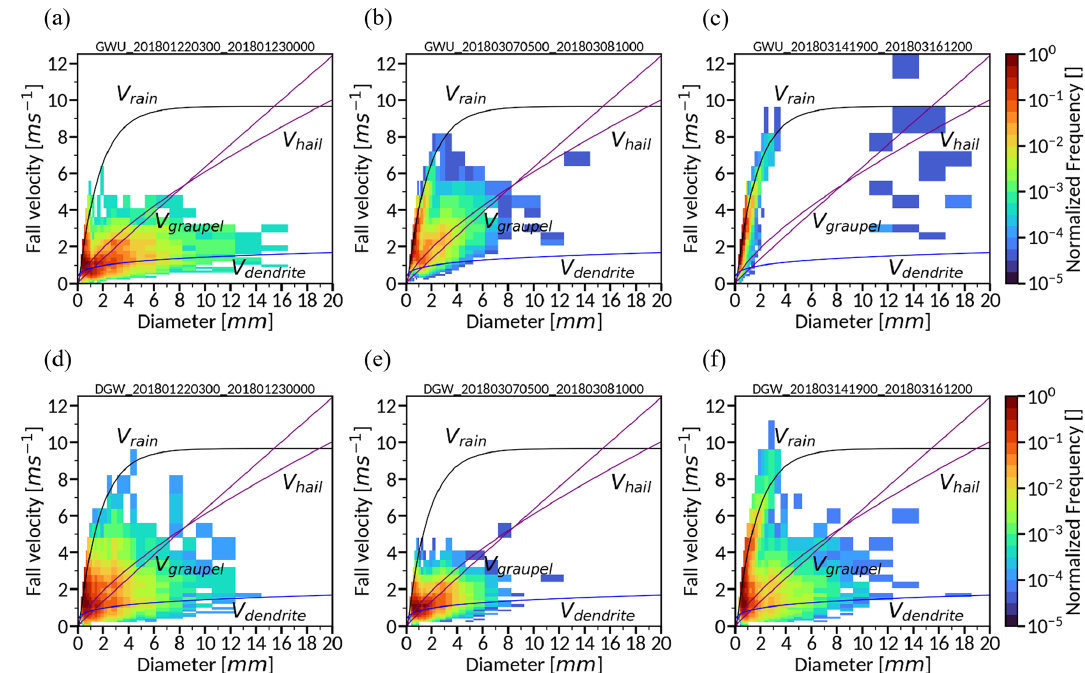
Figure 2. Normalized frequency of the measured precipitation particle fall velocity as a function of diameters at the GWU (a–c) and DGW (d–f) sites. Panels (a) and (d) are for case 3, panels (b) and (e) are for case 6, and panels (c) and (f) are for case 7 during the analysis period. The solid lines represent the relationship between the fall velocity and diameter for rain (using the power law fit from the Gunn and Kinzer, 1949, data; Atlas et al., 1973), dendrite (derived from the observed data; Lee et al., 2015), graupel, and hail (derived from the observed data; Heymsfield et al., 2018) at sea